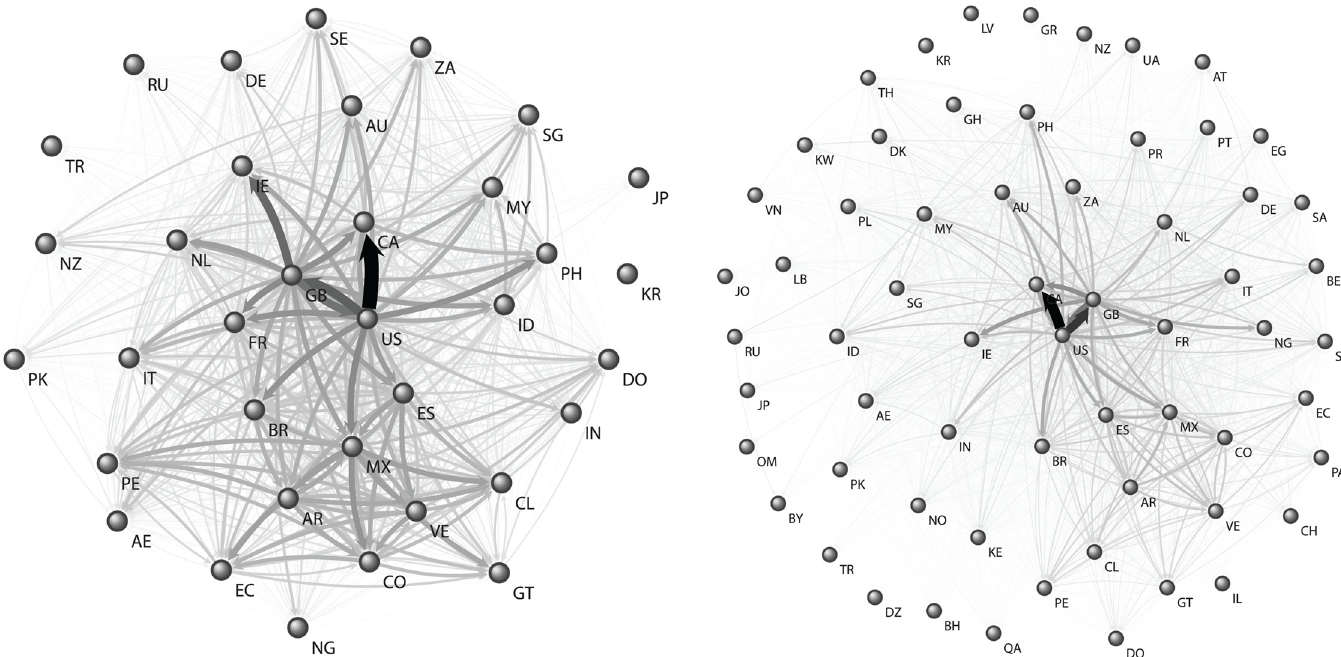
Fig 2. Visual Representation of the International structure of TTs. TT-2013 is shown on the left and TT-2014 on the right. The size and darkness of the links are proportional to their weights.